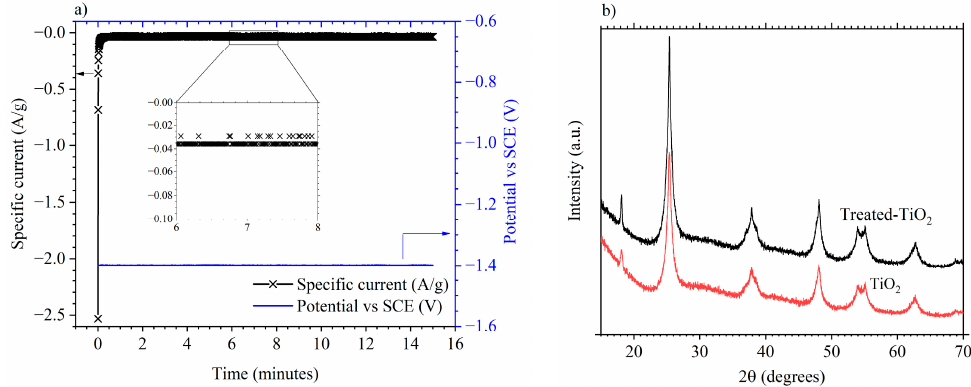
Figure 1. ( a ) Electrochemical reduction of TiO 2 in 1 mol/dm 3 KOH through a potentiostatic hold at − 1.4 V vs. saturated calomel reference electrode (SCE); ( b ) XRD pattern from a TiO 2 (bottom)